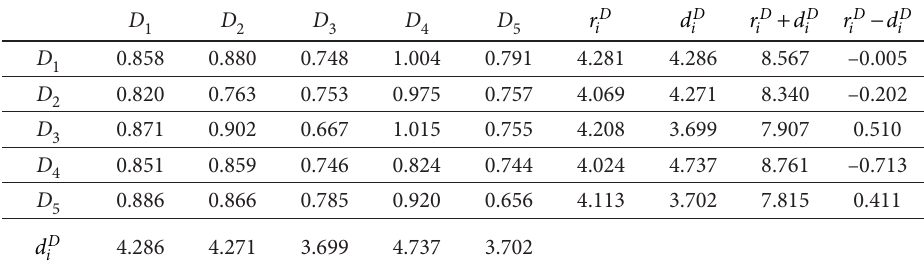
and cause-effect analysis of dimensions D